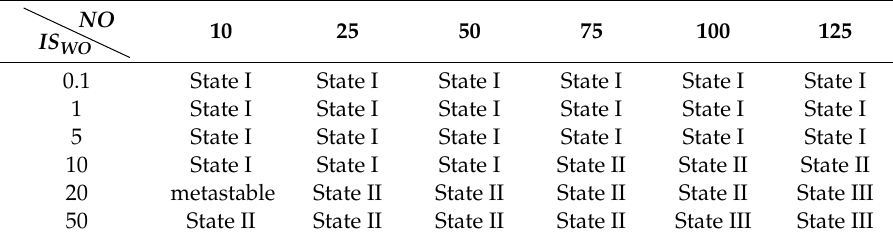
Table 1. Kinetically stable states observed from the simulations in Figure